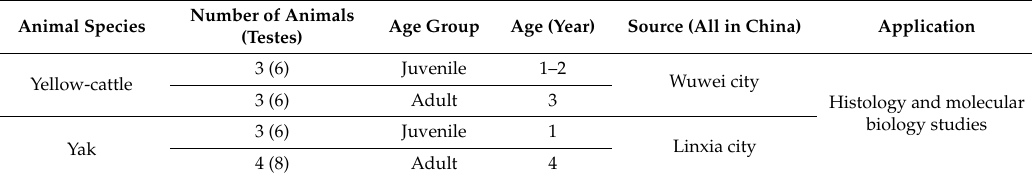
Table 1. Parameters for animal samples